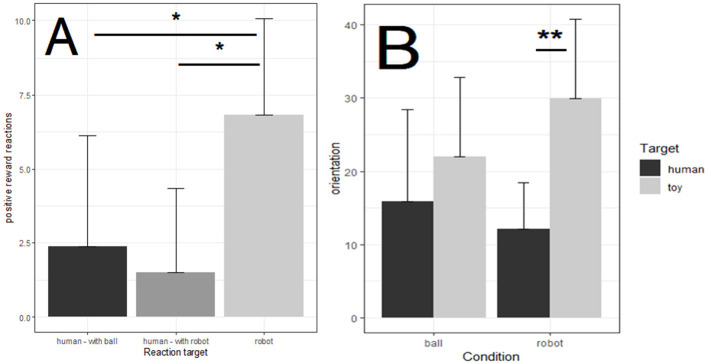
Positive reactions (A) and orientations (B) as a function of Condition (ball, robot). *p < 0.05, **p < 0.01and ***p < 0.001.